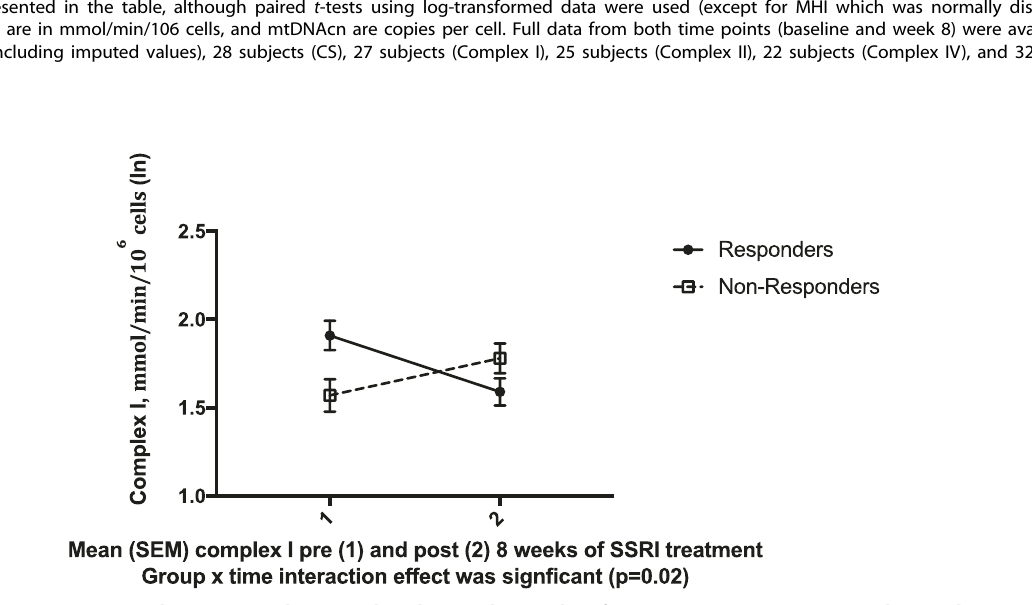
Fig. 1 Change in PBMCs RC Complex I activity between baseline and 8 weeks of SSRI treatment SSRI responders and nonresponders. Complex 1 activity is plotted on the y-axis and time point (baseline and week 8) on the x-axis.